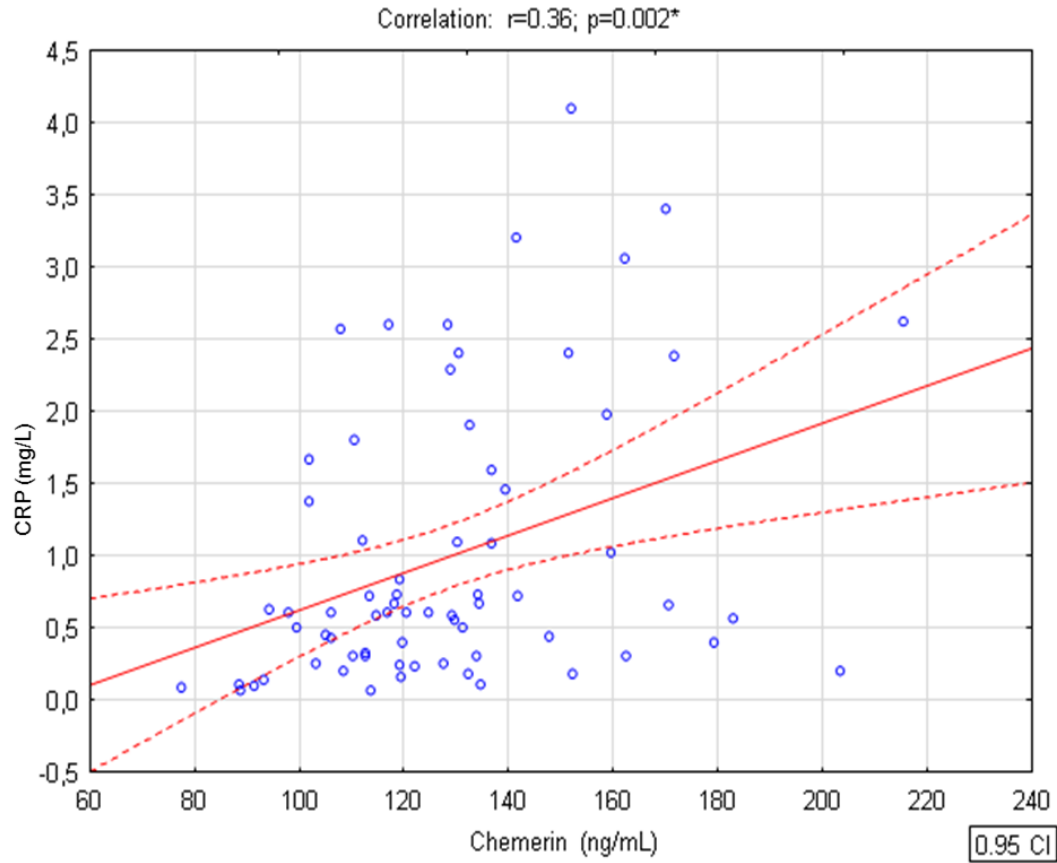
Figure 1. Correlation between serum chemerin and C-reactive protein (CRP) concentrations in the whole group of studied children. r , Pearson’s correlation coefficient